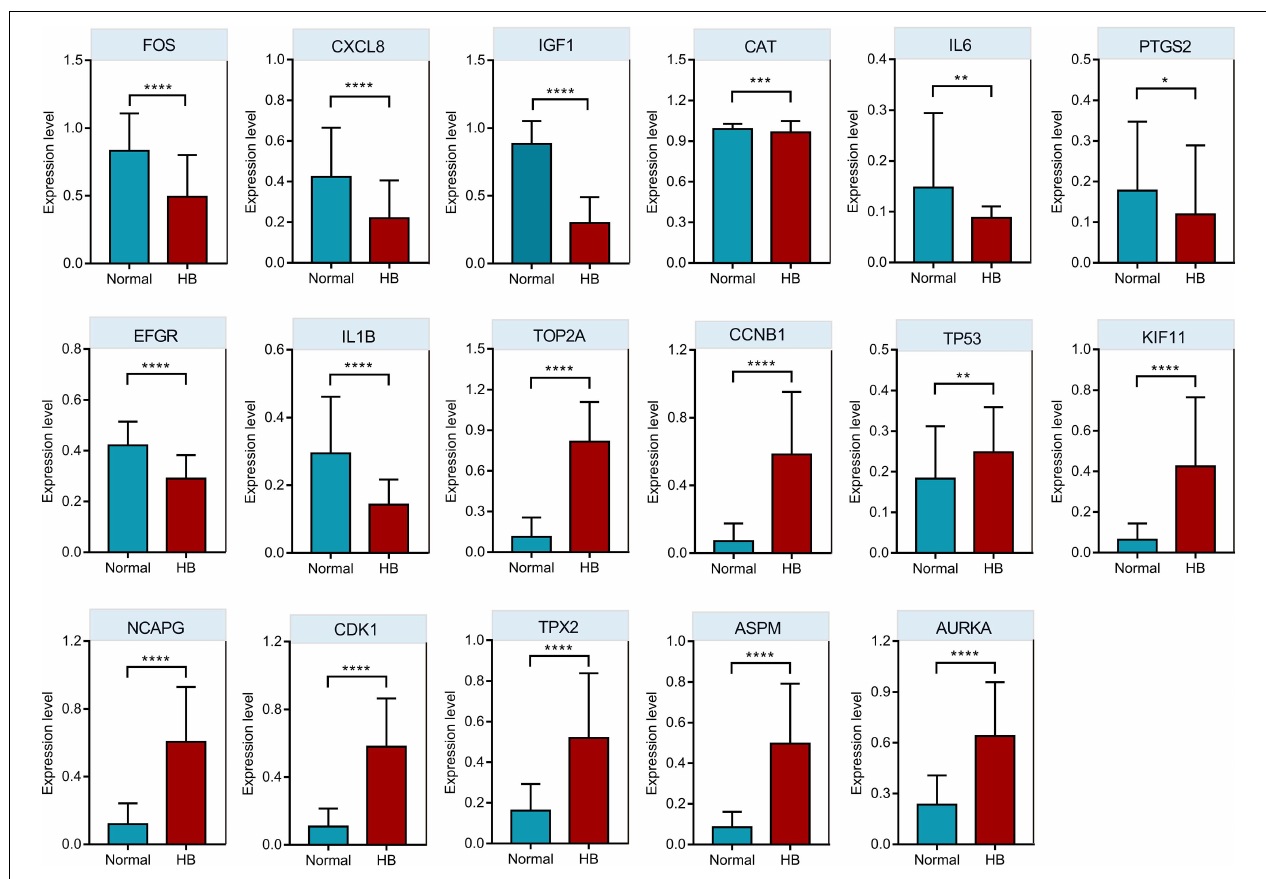
FIGURE 7 | The comparison of hub genes expression levels in HB and normal liver tissue samples from Oncopression database. After UPC-normalization, the expression levels range from 0 to 1 where 0 and 1 indicate no expression and the highest expression, respectively. * P value < 0.05; ** P value < 0.01; *** P value < 0.001; **** P value <